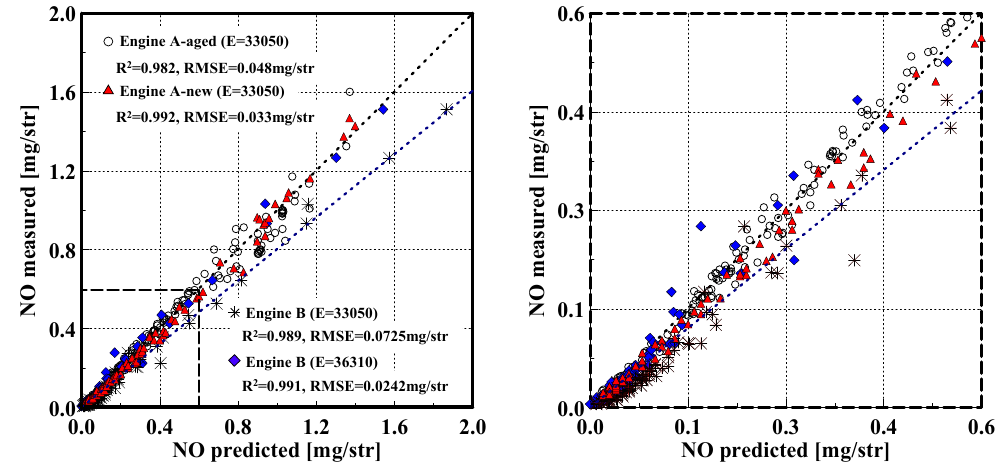
Figure 9. Steady-state NO mass of estimated using the model compared to the measured values in engine A-aged ( n = 220, ○ ), engine A-new ( n = 91, △ ), engine B ( n = 99, *) with the same constant ( E = 33,050) as engine-A, and engine B ( n = 99, ◇ ) with the constant ( E = 36,310) recalibrated, and an enlargement of a relatively small range (NO < 0.6 mg/str) of the estimation results are shown. In addition, the NO estimation results from engine B with a calibration constant identical to the one applied to engine A-aged and A-new still shows a good correlation value R 2 of 0.989, although the RMSE value increased compared to the predicted results of engine A (Note that ω in Equation (12) re- scaled in the same manner using the maximum values used in the engine B experimental conditions).